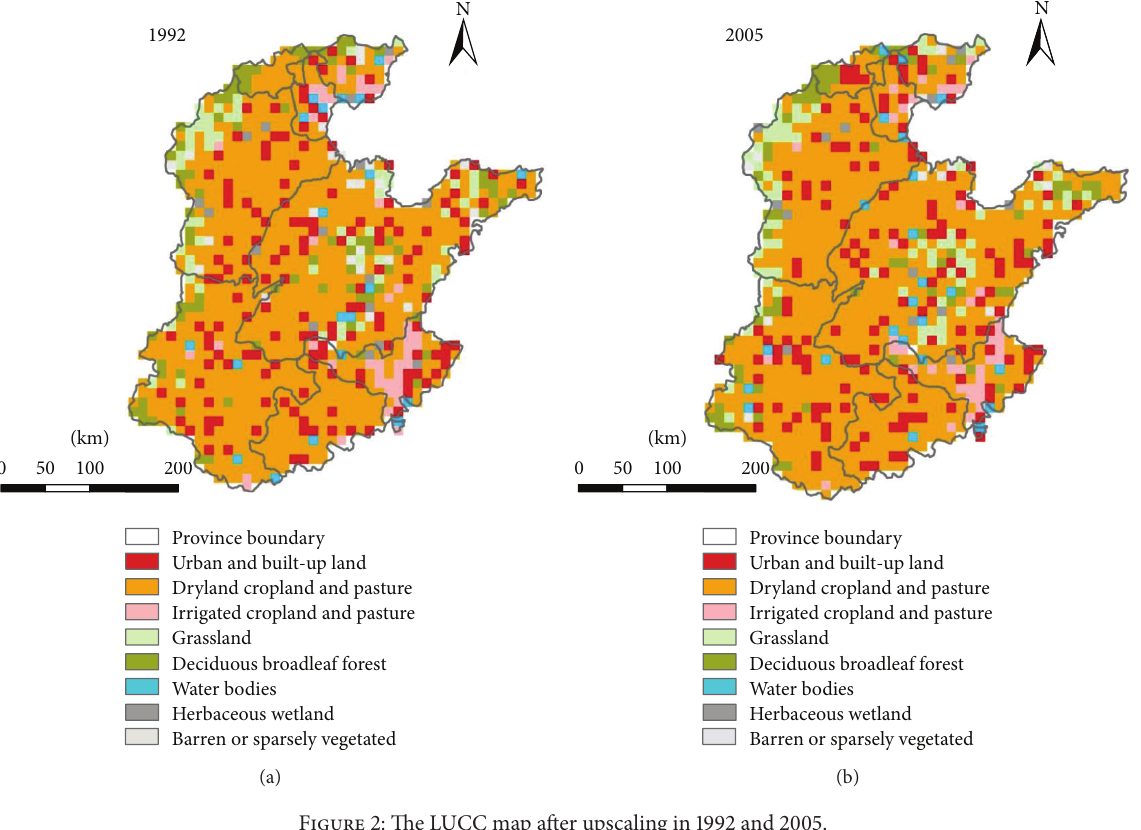
Figure 2: The LUCC map after upscaling in 1992 and 2005.